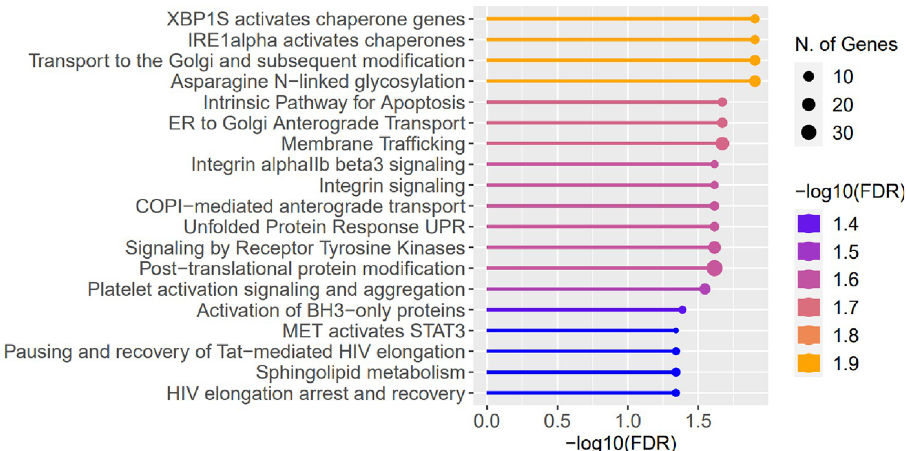
Fig 3. Results of pathway enrichment analysis. Results of pathway enrichment analysis for genes which expression in corneal epithelium was found to be correlated with the eye rubbing manner. The type of eye rubbing was indicated in response to presented photographs, included in Fig 1. Transcriptome data was obtained for males and females from both study groups. The Reactome database was chosen as the source of the